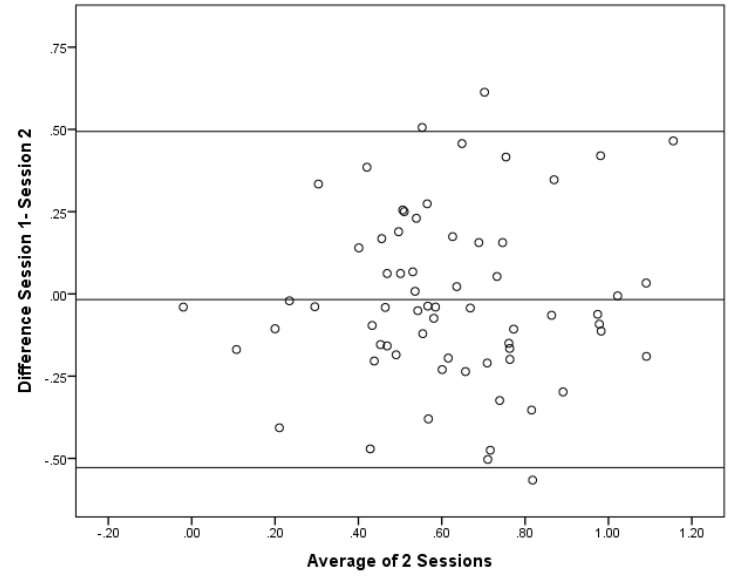
Figure 4. Bland–Altman Plot for the Full sample ( n = 66).